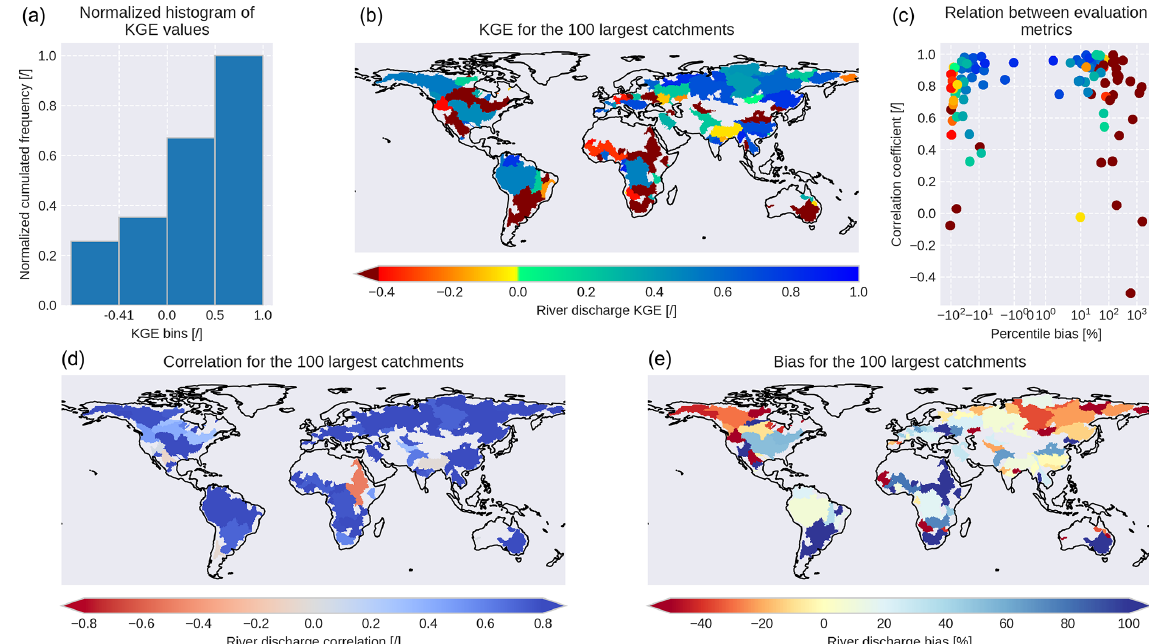
Figure 8. Kling–Gupta efficiency (KGE) of simulated river discharge climatologies for the world’s 100 largest catchments compared to GRDC observations (GRDC, 2020): the upper panels show the cumulative histogram (a) of the spatial distribution (b) of KGE values and its relation (c) to the temporal correlation and percentile bias. The spatial distribution of the latter two metrics are shown in the lower